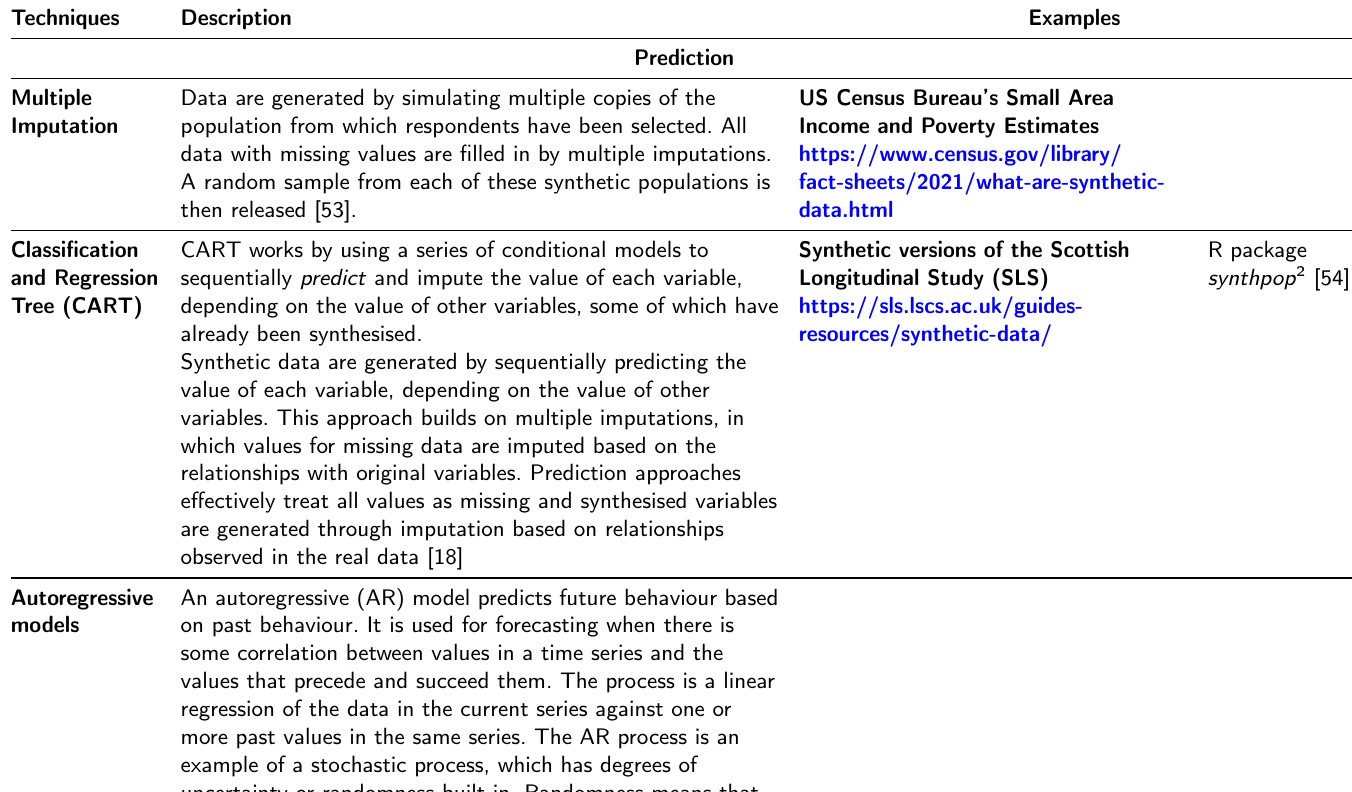
Table 2: Methods and examples of synthetic data generation (further explanations are provided in the Glossary in Supplementary Table